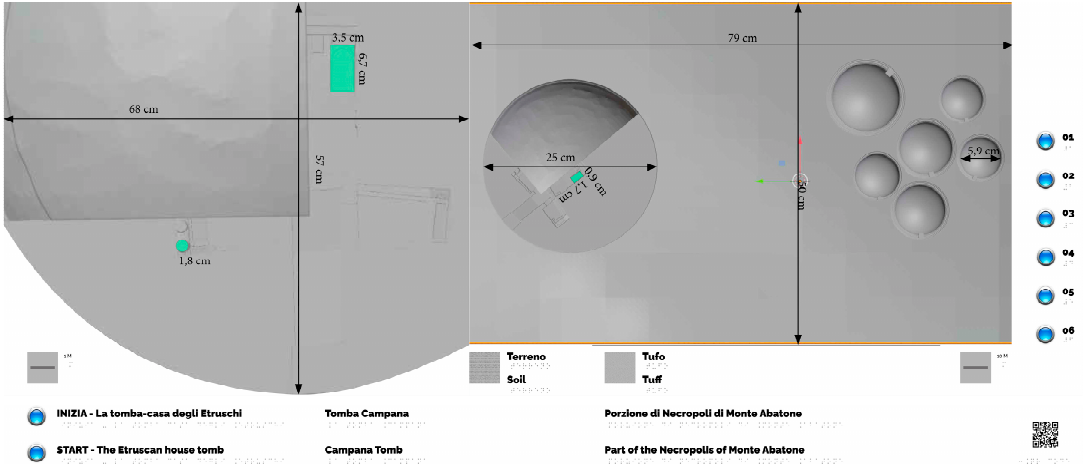
Figure 14. e-Archeo Tactile: TUI layout (by Collettivo Digitale and accessibility experts).